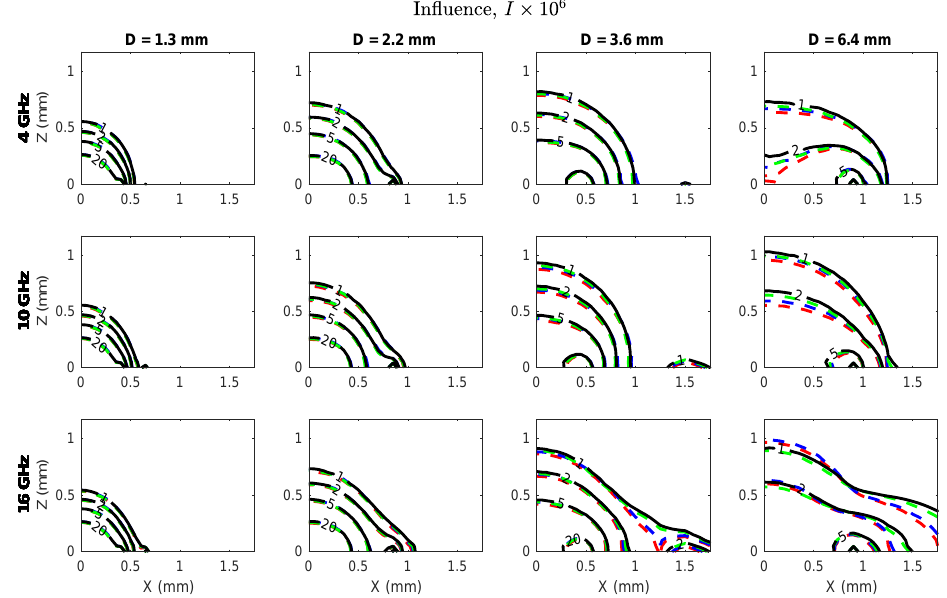
Figure 6. Influence maps for four combinations of background coefficient and contrast levels: 1.0 and 0.5 (solid black), 1.0 and 0.75 (dotted green), 0.75 and 0.5 (dotted blue), 0.75 and 0.75 (dotted red). Contrast had minimal impact on influence, while changes due to background permittivity were commensurate with changes in the electric field intensity around the